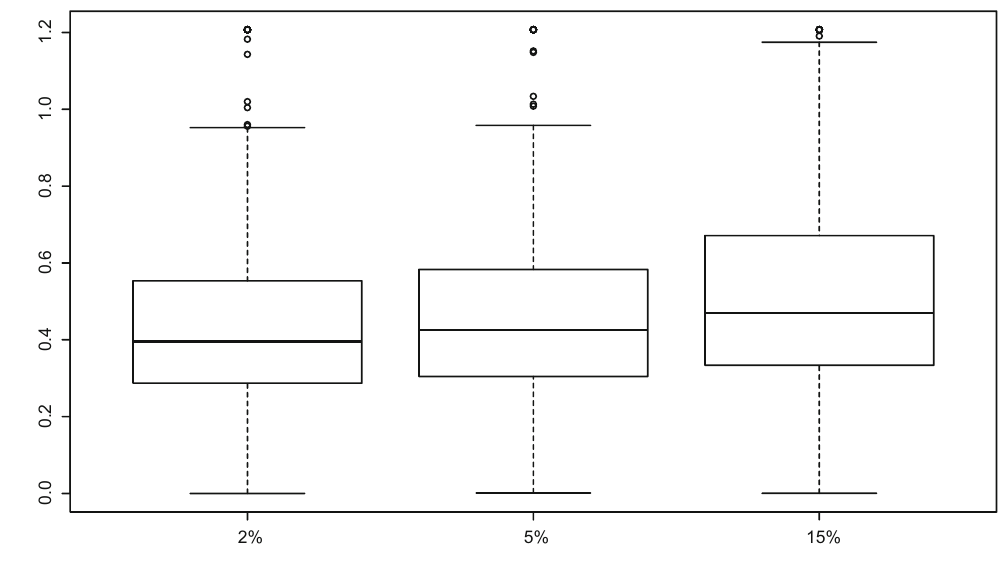
Fig. 2 Distribution of the MSE obtained for different CR for n = 300 Table 1 Numerical summary of the distribution of the MSE, for N = 400, obtained for n = 50 , 100 , 200 and 300 CR = 2% CR = 7% CR = 16% CR = 49% n = 50